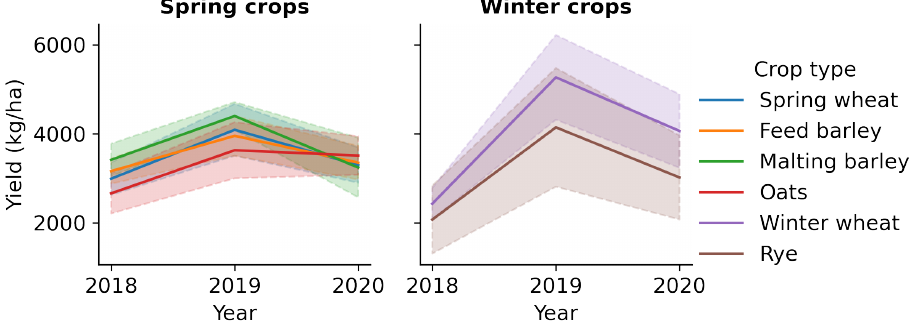
Figure 2. The mean and 68% bootstrap confidence interval (dashed lines) of the regional crop yields in the study area according to the crop production statistics [64] in